Question: What style of plot is this figure drawn as?
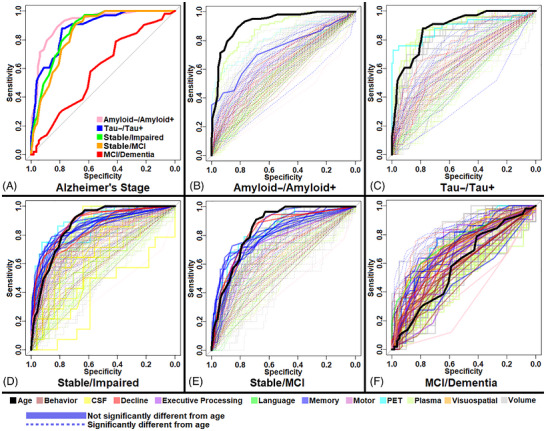
Answer: line